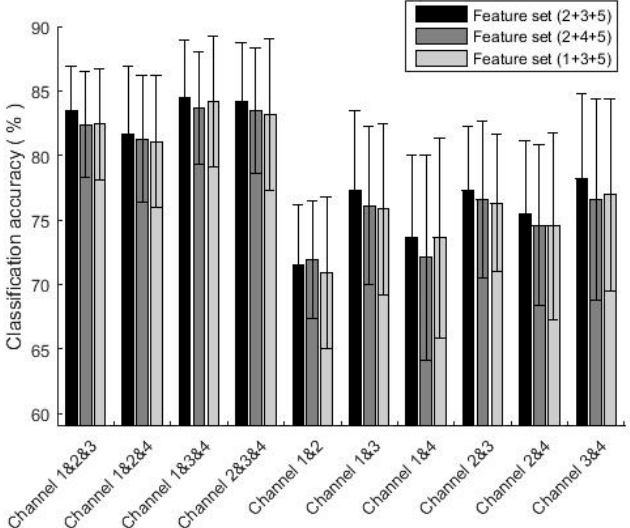
Figure 8. The classification accuracy of different feature sets based on the combinations of different channels.